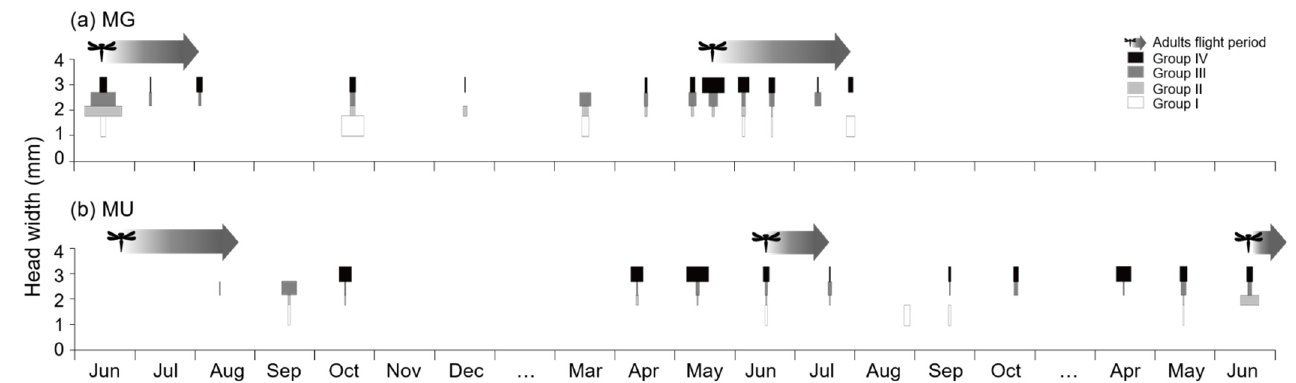
Figure 7. The size–frequency distribution of Nannophya koreana larvae based on the groups using Hcap analysis. Arrows present the flight period of N. koreana adults. Width of horizontal white, light-gray, dark-gray, and black color bars indicate the proportions of larvae in Group I, II, III, and IV, respectively. The study period was from August 2006 to July 2007 in MG ( a ) and from June 2019 to June 2021 in MU ( b ).